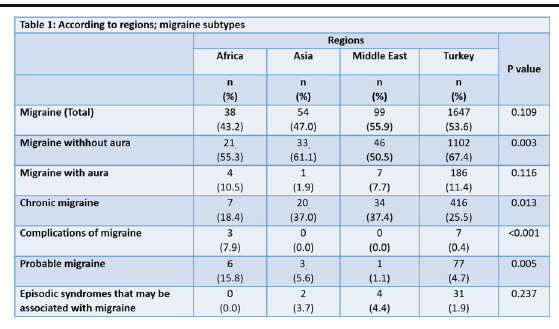
Table 1 (abstract A256). According to regions; migraine